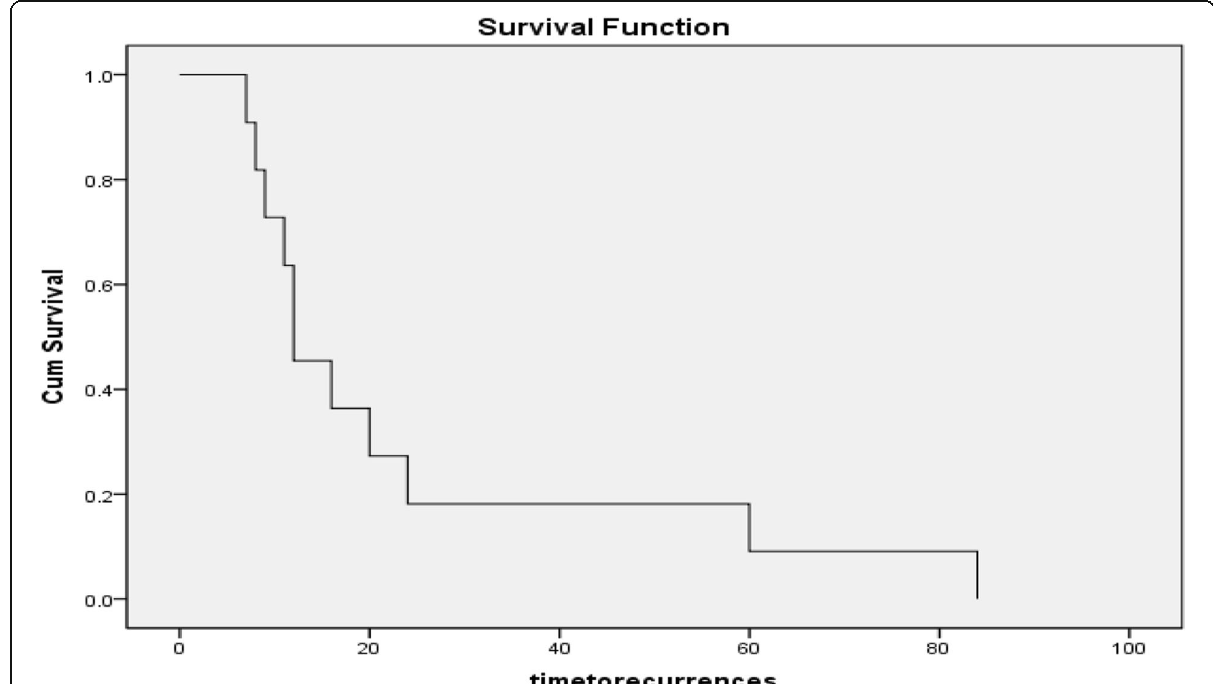
Fig. 1 Mean time to recurrence post-LT of the studied